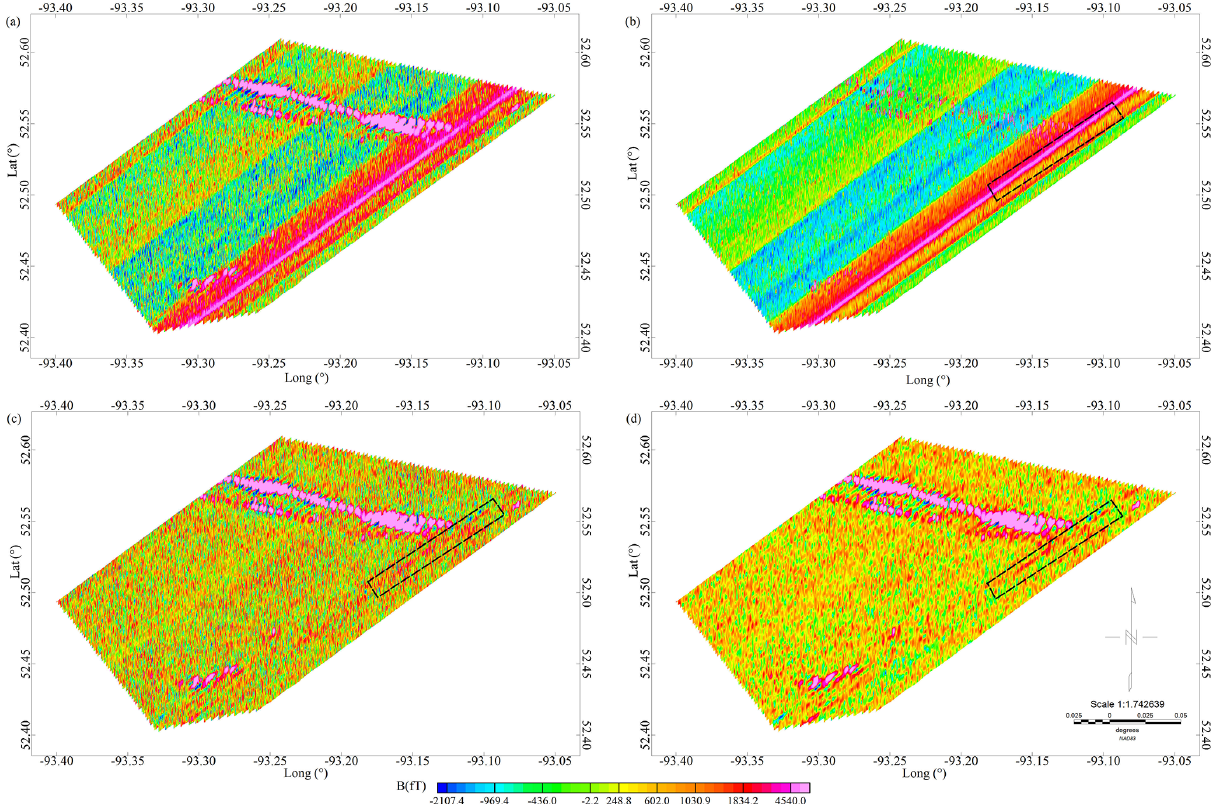
Figure 3. The AEM data leveling. (a) Raw AEM data. (b) The preprocessed smooth field. (c) Leveled data by the unidirectional variational model algorithm. (d) The data processed by Fugro Airborne Surveys.